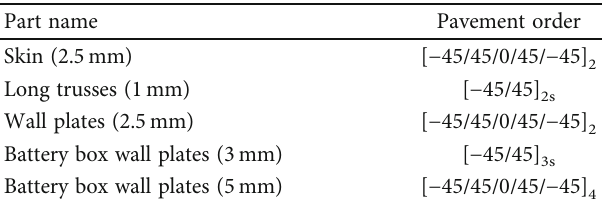
Figure 8: Bending at the edge.